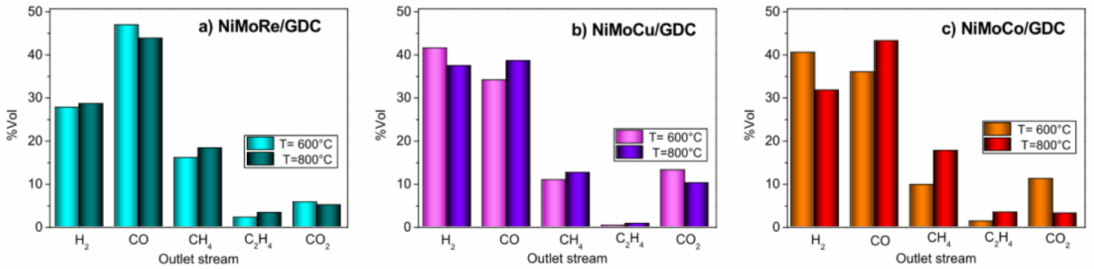
Products distribution of auto-thermal reforming (ATR) reaction catalyzed by: